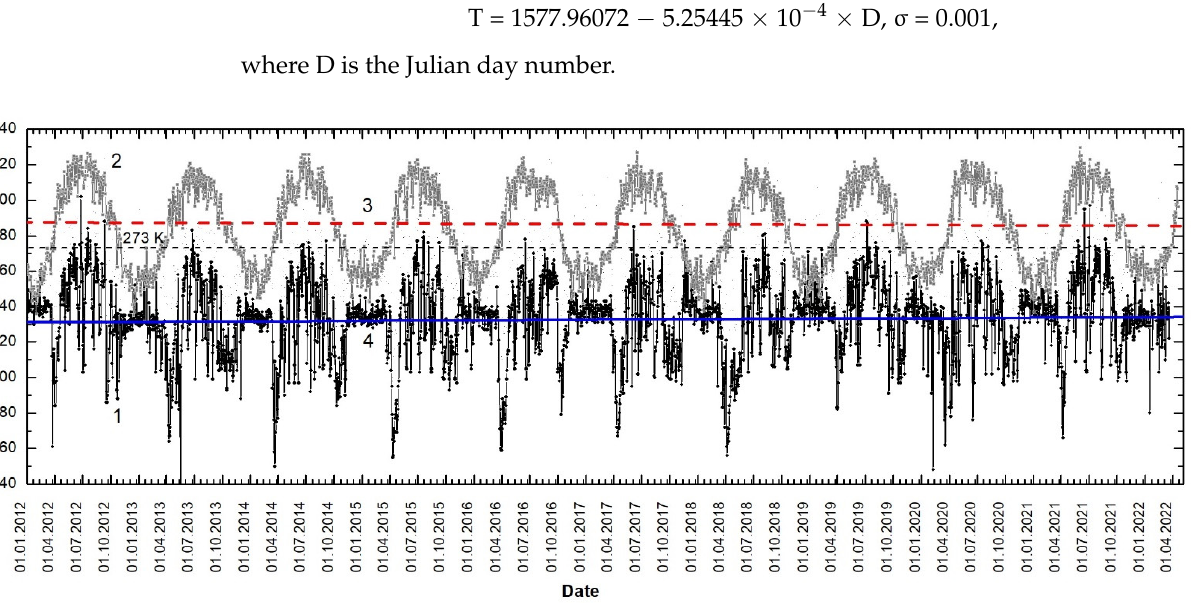
Figure 3. Dependence of emissivity ( χ ) on volume fraction of water in soil (W).